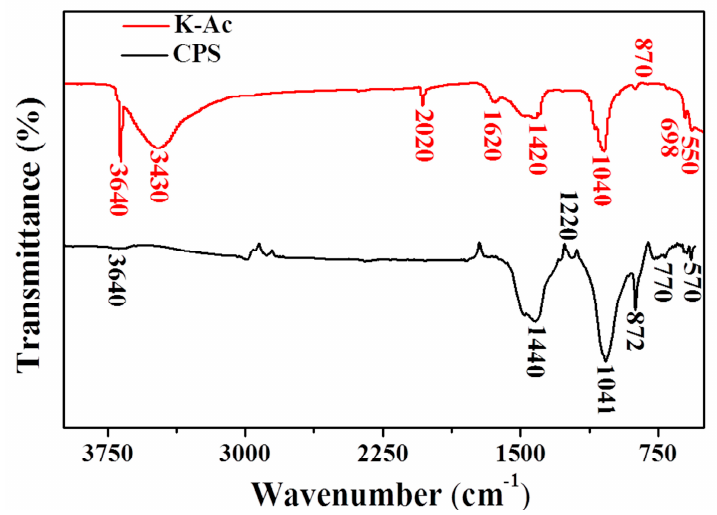
Figure 6. FTIR spectra of CPS and K-Ac.